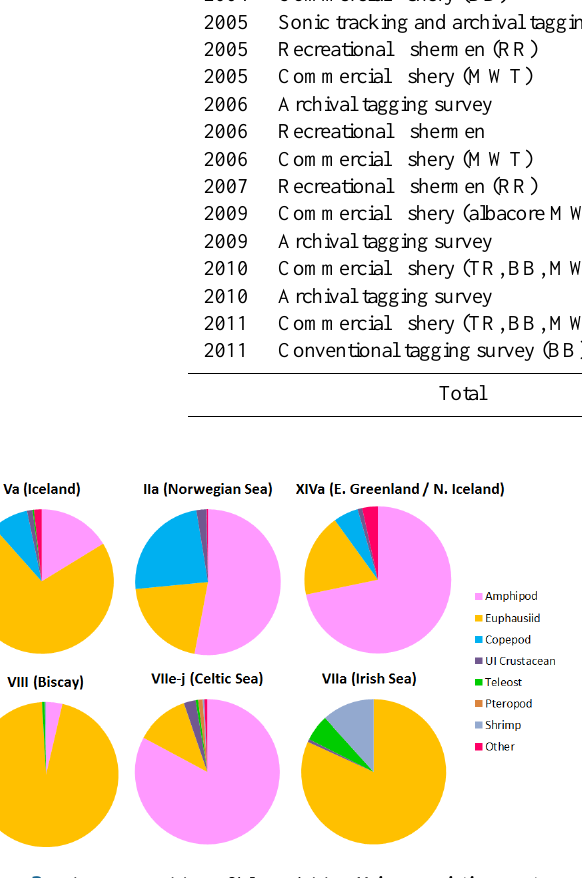
Figure 3. Diet composition of blue whiting Micromesistius poutas- sou in different parts of the northeast Atlantic (ICES